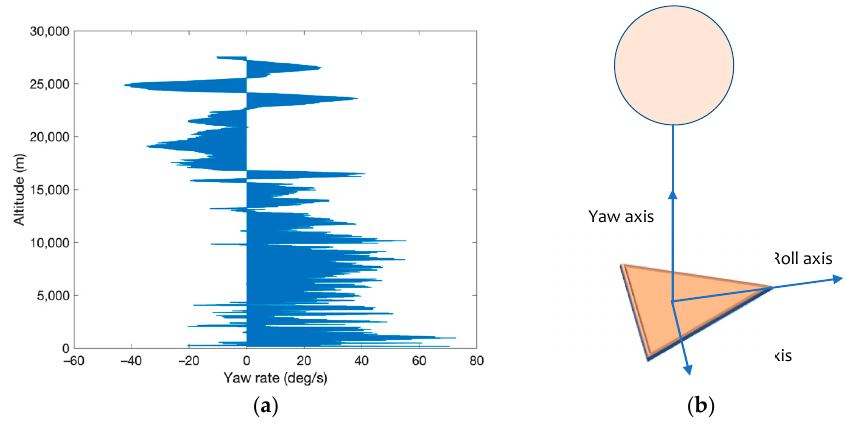
Figure 20. ( a ) Yaw rate as a function of altitude. ( b ) Orientation of the gondola body axes in the accelerations analysis, the x - and y -axes correspond to the pitch and roll axis respectively, while the z-axis corresponds to the yaw axis.